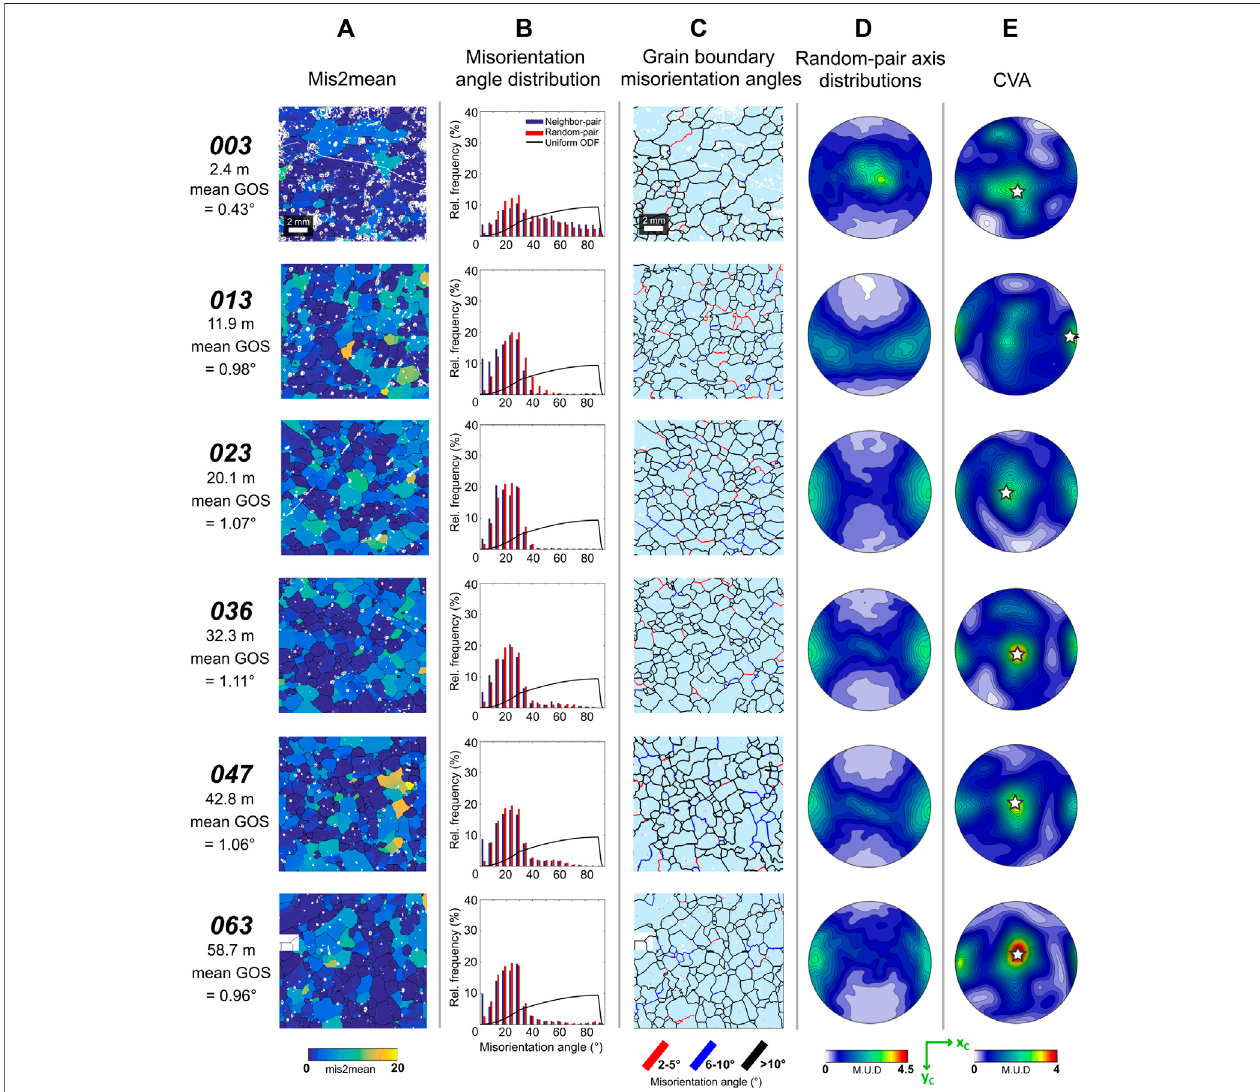
FIGURE 10 | Misorientation distribution analysis for representative Priestley Glacier samples in the “ c -axis maximum ” reference frame. (A) Maps of intergranular misorientation relative to the mean orientation of a grain. Mean grain orientation spread (GOS), or misorientation to the mean orientation of a grain, is given for each sample. (B) Misorientation angle distribution for all neighbor-pair and random-pair grain boundaries plotted against a distribution for a uniform fabric. (C) Maps of grain boundarymisorientation. (D) Random-pairmisorientationaxisdistributionforallgrainboundaries( > 10 ° ).Misorientationaxesbetweenpixelsthatarenotnecessarily neighboring. (E) Crystallographic vorticity analysis gives a dominant vorticity axis for a sample from the dispersion axes of individual deformed (GOS values > 1 ° ) grains (see section 4.4 ; Michels et al., 2015). The aggregate dispersion axis, or vorticity axis, is denoted by a white star.